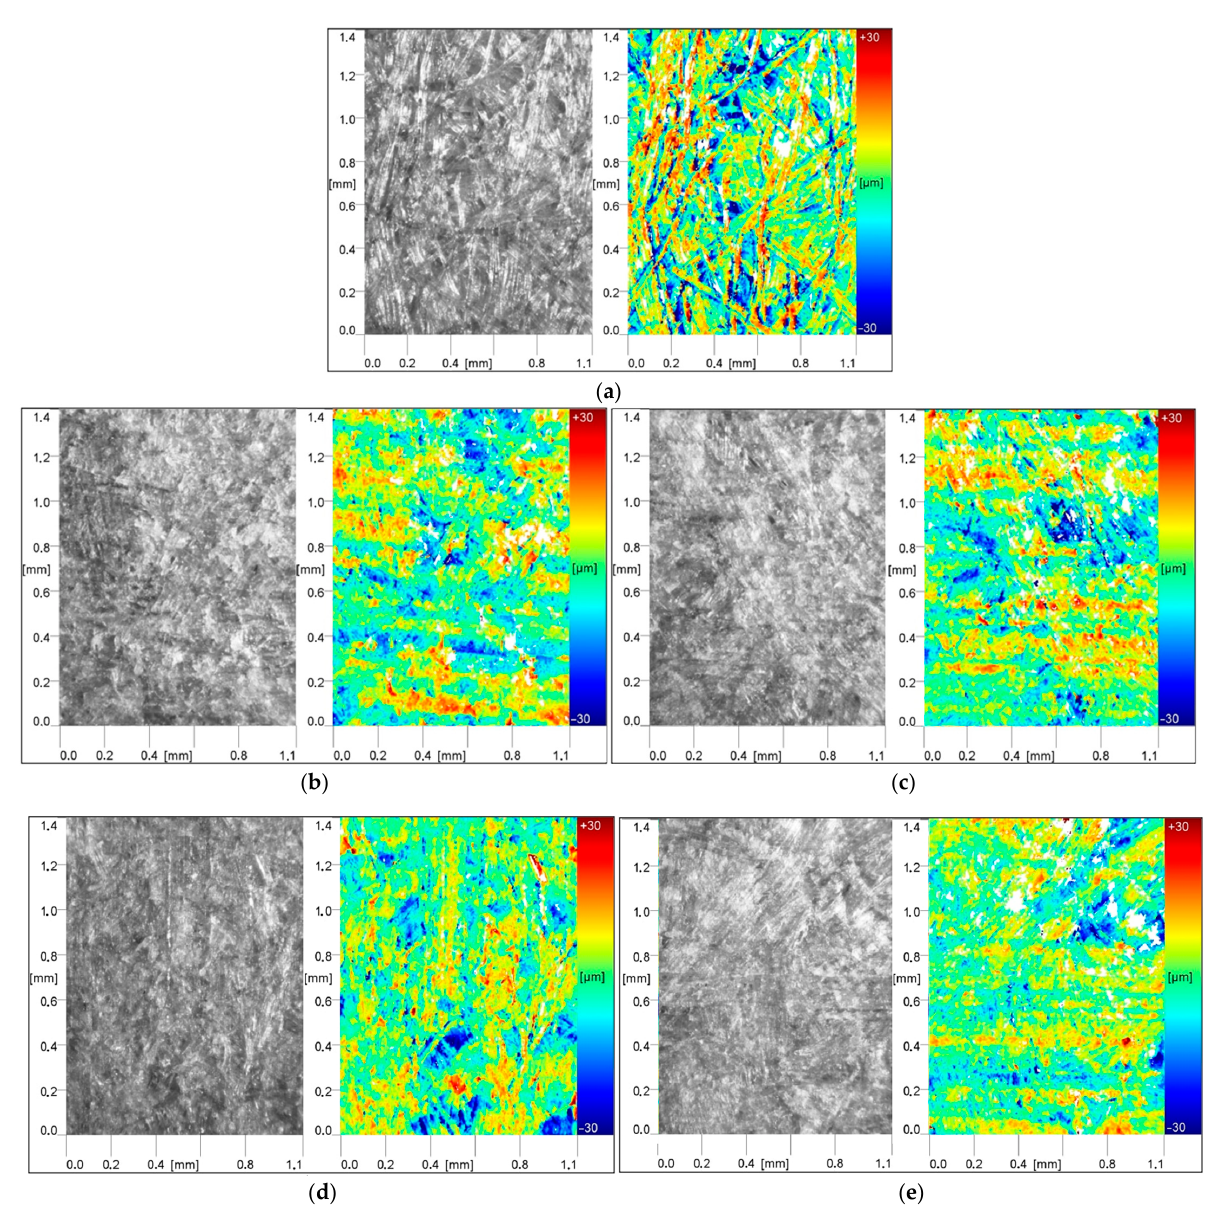
Figure 7. View of the surface of the C board ( a ) before sanding ( b ) sanding program P150, feeding speed 25 m/min ( c ) sanding program P150, feeding speed 50 m/min ( d ) sanding program P150/P220, feeding speed 25 m/min ( e ) sanding program P150/P220, feeding speed 50 m/min.